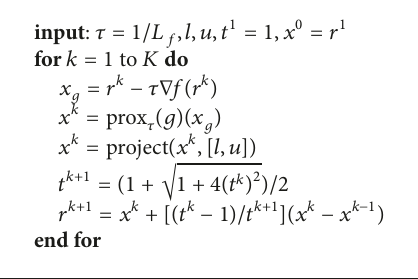
Algorithm 1: Outline of FISTA (Fast Iterative